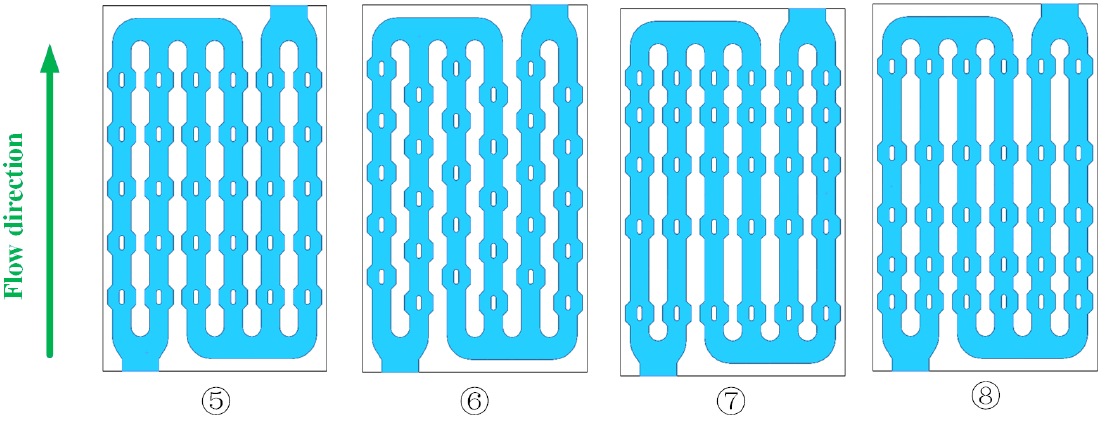
Figure 10. Different distributions of disturbance structures.